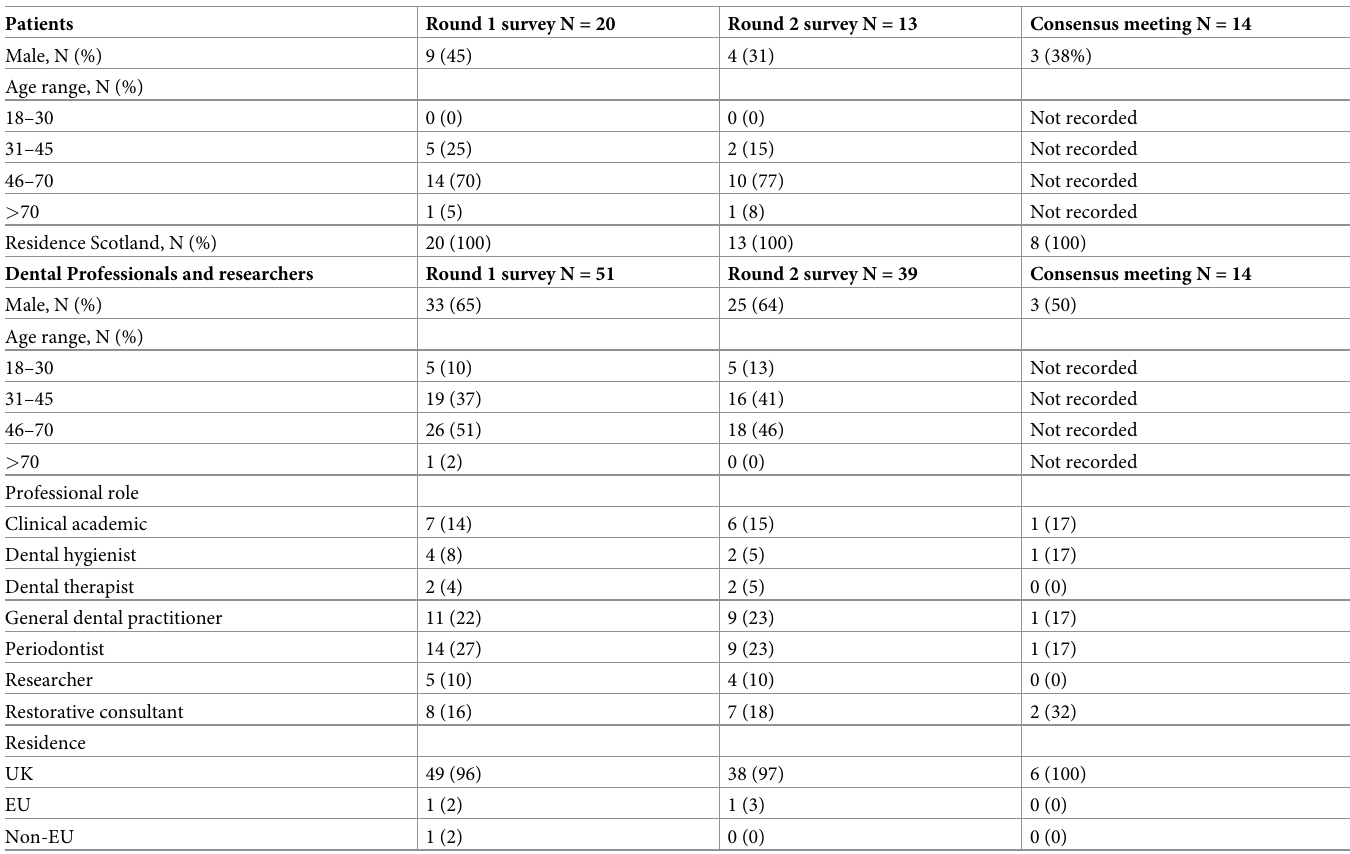
Table 2. Demographics of participants of e-Delphi study and consensus meeting.